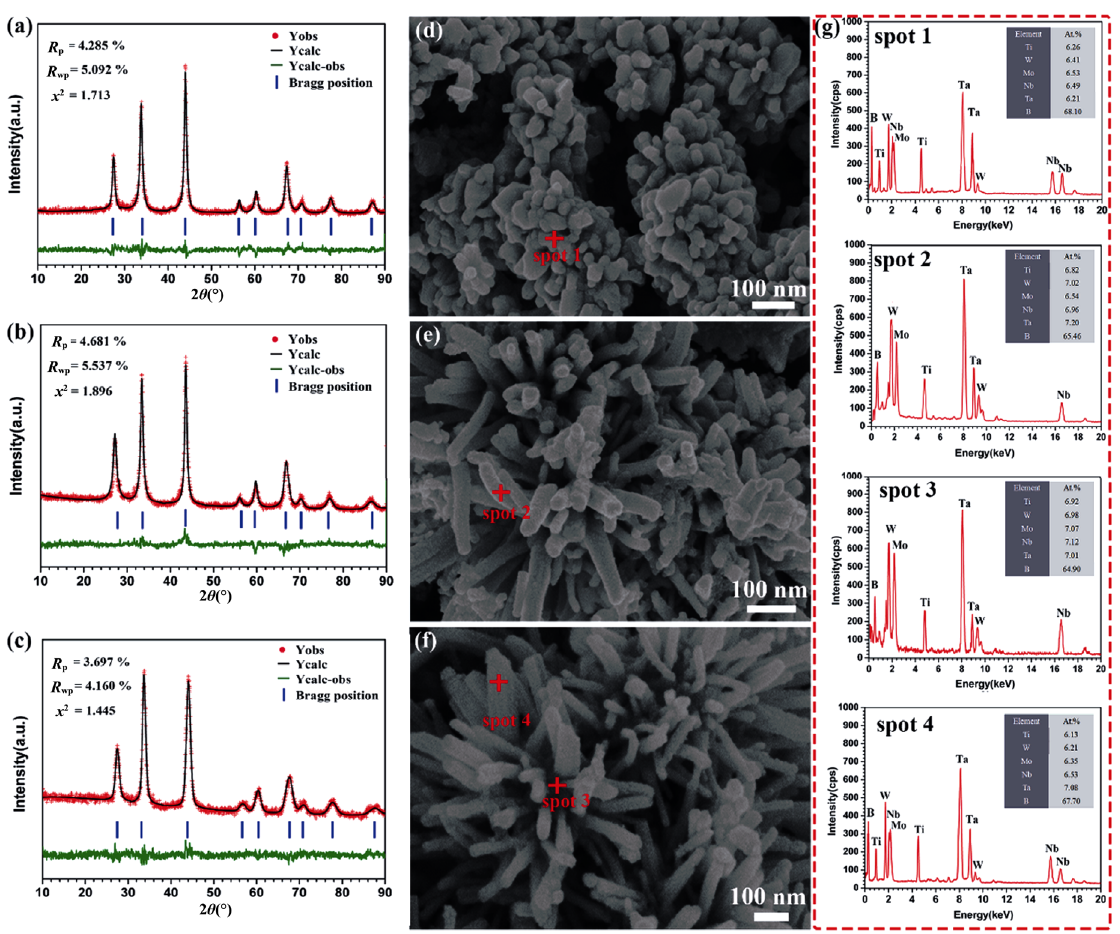
Fig. 5 XRD and SEM characterizations of the as-synthesized products at 1423 K for the different holding time: (a) XRD pattern of 10 min along with Rietveld refinement; (b) XRD pattern of 20 min along with Rietveld refinement; (c) XRD pattern of 30 min along with Rietveld refinement; (d) SEM image of 10 min; (e) SEM image of 20 min; (f) SEM image of 30 min, (g) EDS analyses of the as-synthesized samples in